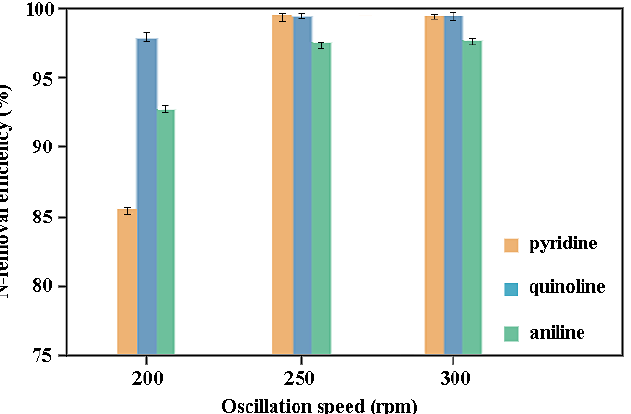
Figure 7. N-removal efficiency of the best IL with different oscillation speeds for pyridine, quinoline, and aniline. and